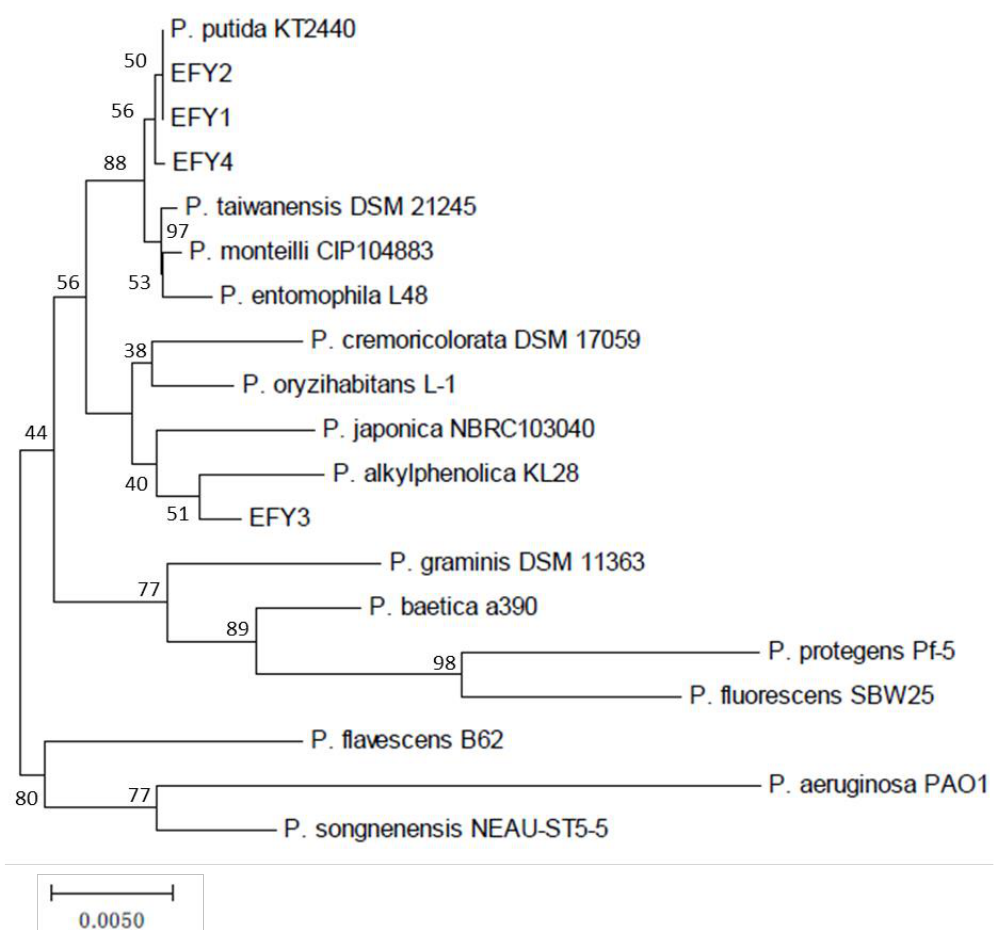
Figure 1. Comparative 16S rRNA gene sequence analysis of Pseudomonas sp. strains EFY1, EFY2, EFY3, and EFY4, and representative related strains from GenBank. The significance of each branch is indicated by a bootstrap for 1000 subsets. The percentage of replicate trees in which the associated taxa clustered together in the bootstrap test (1000 replicates) are shown next to the branches.